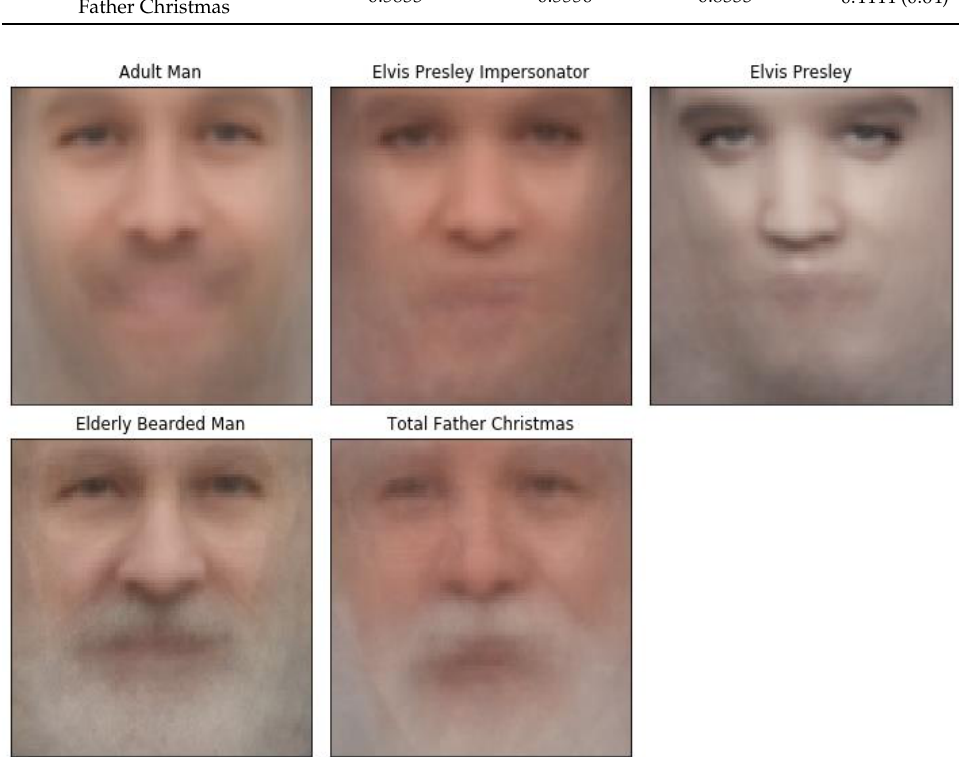
Figure 4. Facial Averages for each group: Adult Man (upper left panel), Elvis Presley Impersonator (upper middle panel), Elvis Presley (upper right panel), Elderly Bearded Man (lower left panel) and Total Father Christmas (lower middle panel).